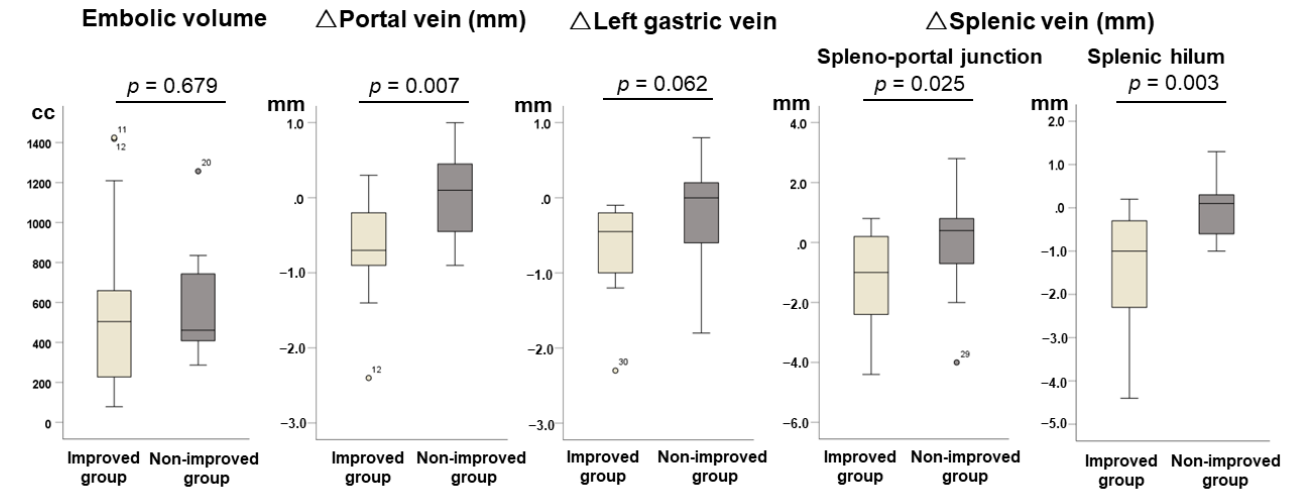
Figure 3 . Radiological changes before and after partial spleen embolization.